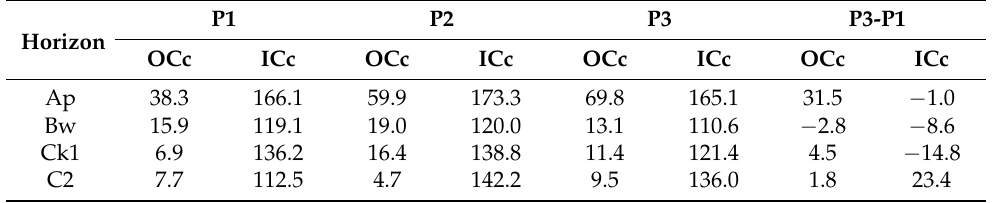
Table 2. Organic carbon capture (OCc) and inorganic carbon capture (ICc) in the different horizons, in Mg C ha − 1 .